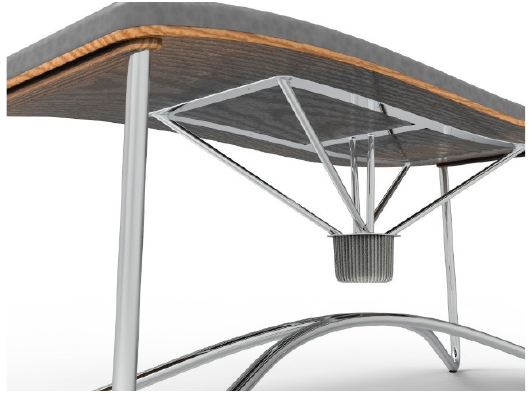
Figure 2. Vibrating lounger VIBRATICS I (from the authors’ archive).